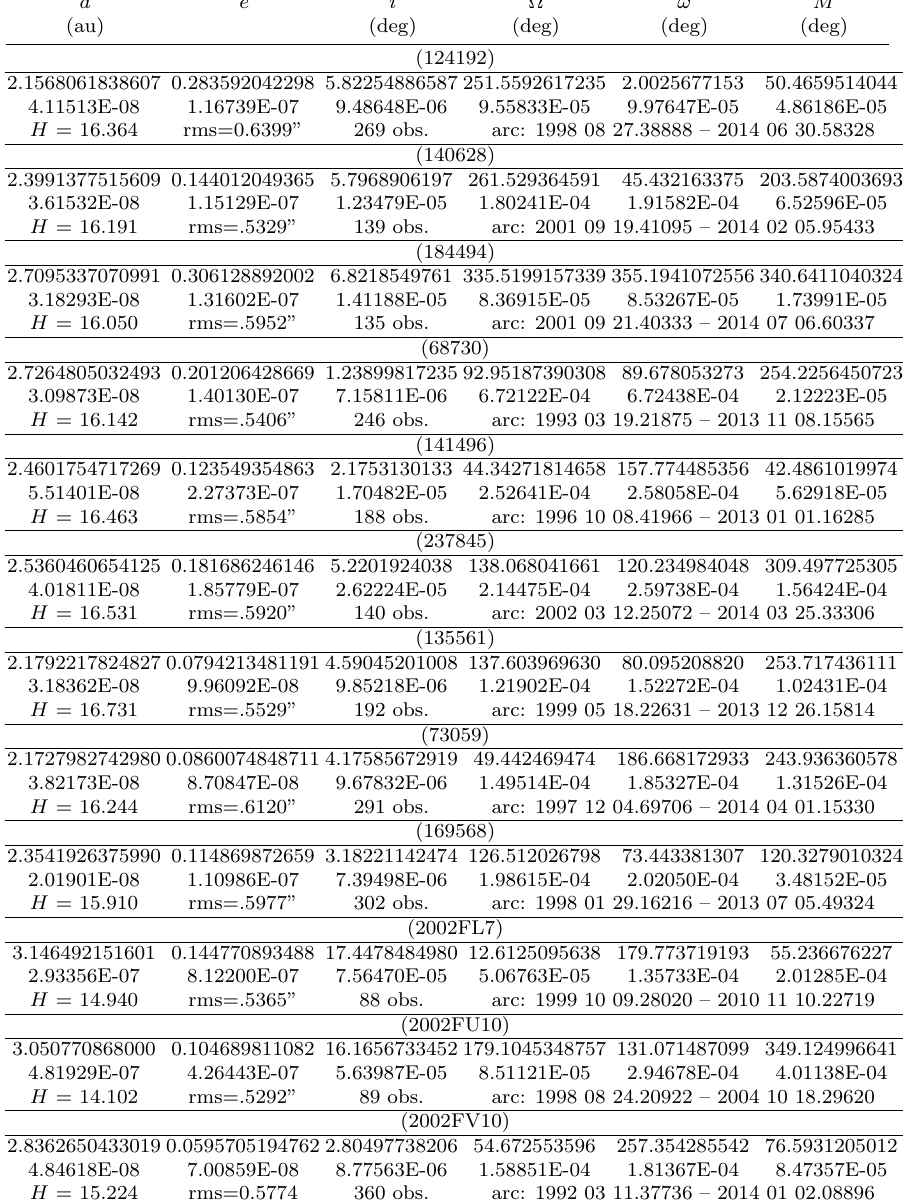
Table 3. High precision orbital elements of the asteroids discovered at the Mol_etai Observatory in 2000{2004. The epoch JD2456800 = 2014 May 23.